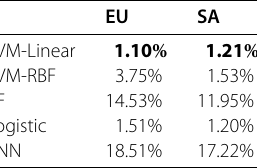
Table 3 Mean average error in predicting gender